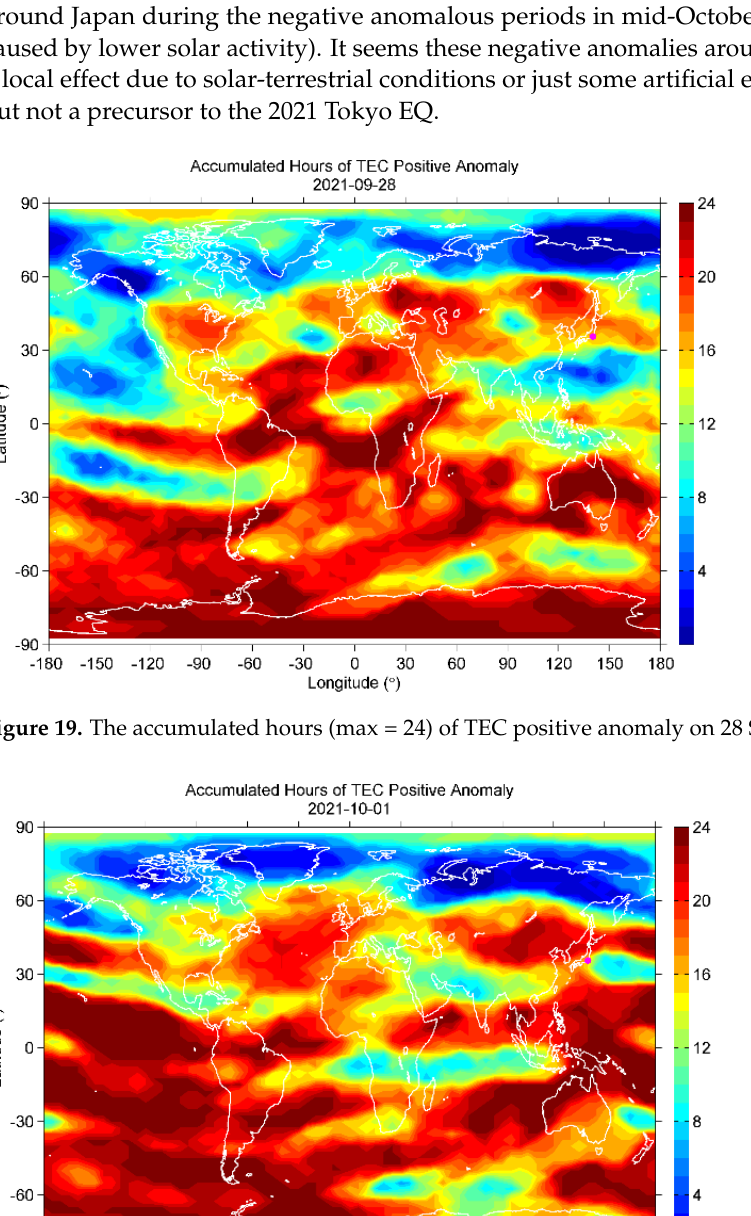
Figure 18. ( a ) TEC, ( b ) Solar radio flux at 10.7 cm (F10.7), and ( c ) Dst index. The red/blue bars in ( a ) refer to positive/negative deviations exceeding ±1.5 σ . A vertical pink line indicates the EQ time.